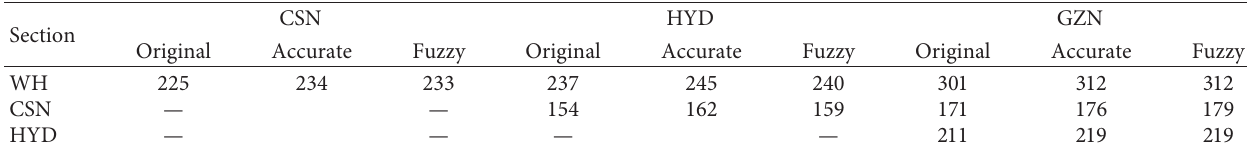
Table 5: The ticket selling result of three